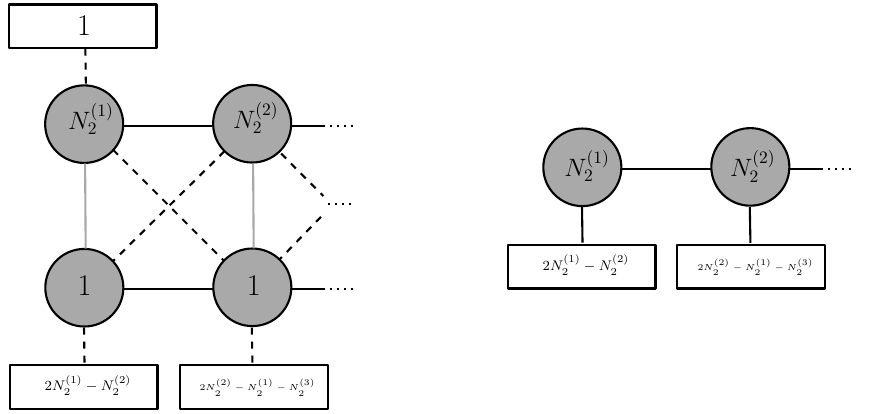
Figure 4 . Left: 2d (0,4) quiver CFT dual to the AdS 3 (cid:2) S 3 (cid:2) CY 2 (cid:2) I solution. Right: 4d N = 2 quiver CFT with